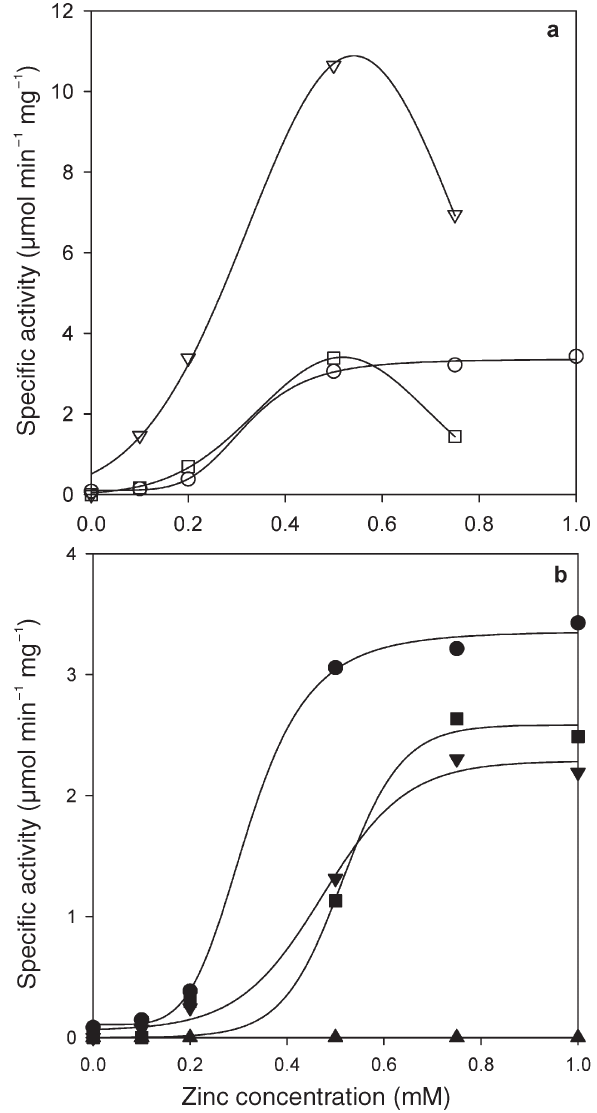
Figure 3. Restoration of activity by zinc ions in sn -glycerol-1-phos- phate (Gro1 P DH). The Gro1 P DH was dialyzed against 50 mM EDTA (pH 8.0) for 24 h at 4 °C, and then against 50 mM Tris-HCl buffer/0.15 M NaCl (pH 8.0). Activity was measured after incubation in 50 mM Tris-HCl buffer/0.15 M NaCl (pH 8.0) containing ZnCl 2 at 4 °C for 1 h. (a) Wild type ( (cid:2) ), D144N ( (cid:3) ) and D144A ( (cid:4) ). (b) Wild type ( (cid:5) ), D191N ( (cid:6) ), H271A ( (cid:7) ) and H287A ( (cid:8)